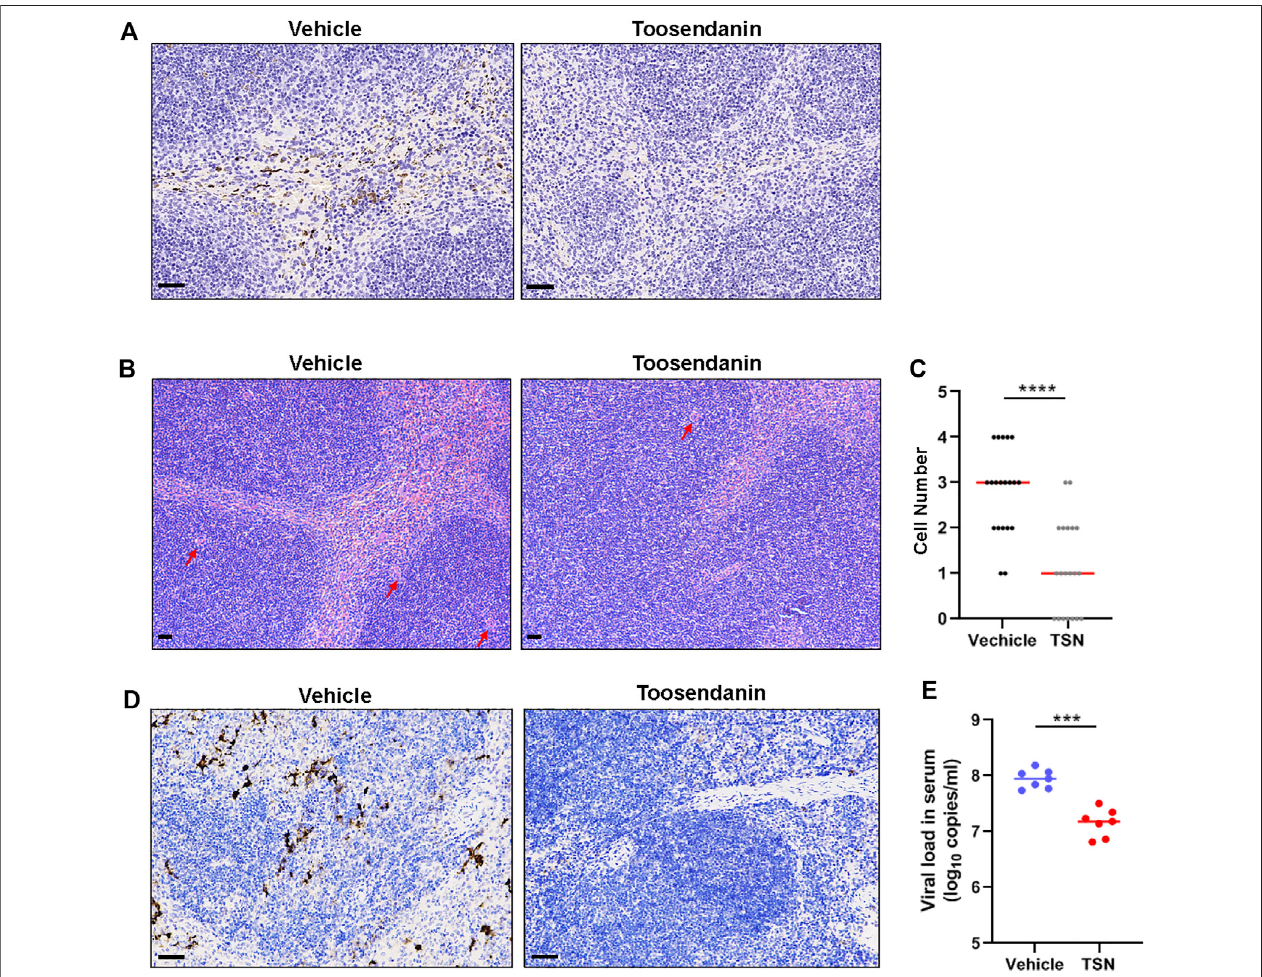
FIGURE5| ToosendanininhibitsSFTSVinfectioninmousemodels. (A – C) C57BL/6werepretreatedwithtoosendaninfor3 daysandinfectedintraperitoneallywith SFTSV (10 5 FFU). Toosendanin (1 mg/kg/d) or vehicle was administered daily. Spleen samples were collected from mice at 3 days post infection for immunostaining of viralnucleocapsidprotein (A) ,andH&Estaining (B) . (C) Quanti fi cationofmegakaryocytesinspleens. (D,E) C57BL/6miceweretreatedwithanti-IFNAR1IgG1 dayprior totheinfectionandintraperitoneallyinfectedwith2000FFUofSFTSV.Toosendaninorthesamevolumeofvehiclewasgiventomicebyintraperitonealinjectionwith the dose of 4 mg/kg/d 1 h post infection. Spleen and serum samples were harvested for immunohistochemistry (D) and viral load determination (E) . TSN, toosendanin. (A,B,D) Barsrepresent 50 μ m.Comparison ofmedianvalues (C) betweentwogroupswasanalyzedbyMann-Whitneytest.**** p < 0.0001.Comparisonofmeanvalues (E) between two groups were analyzed by Mann-Whitney test. ** p < 0.01; *** p <